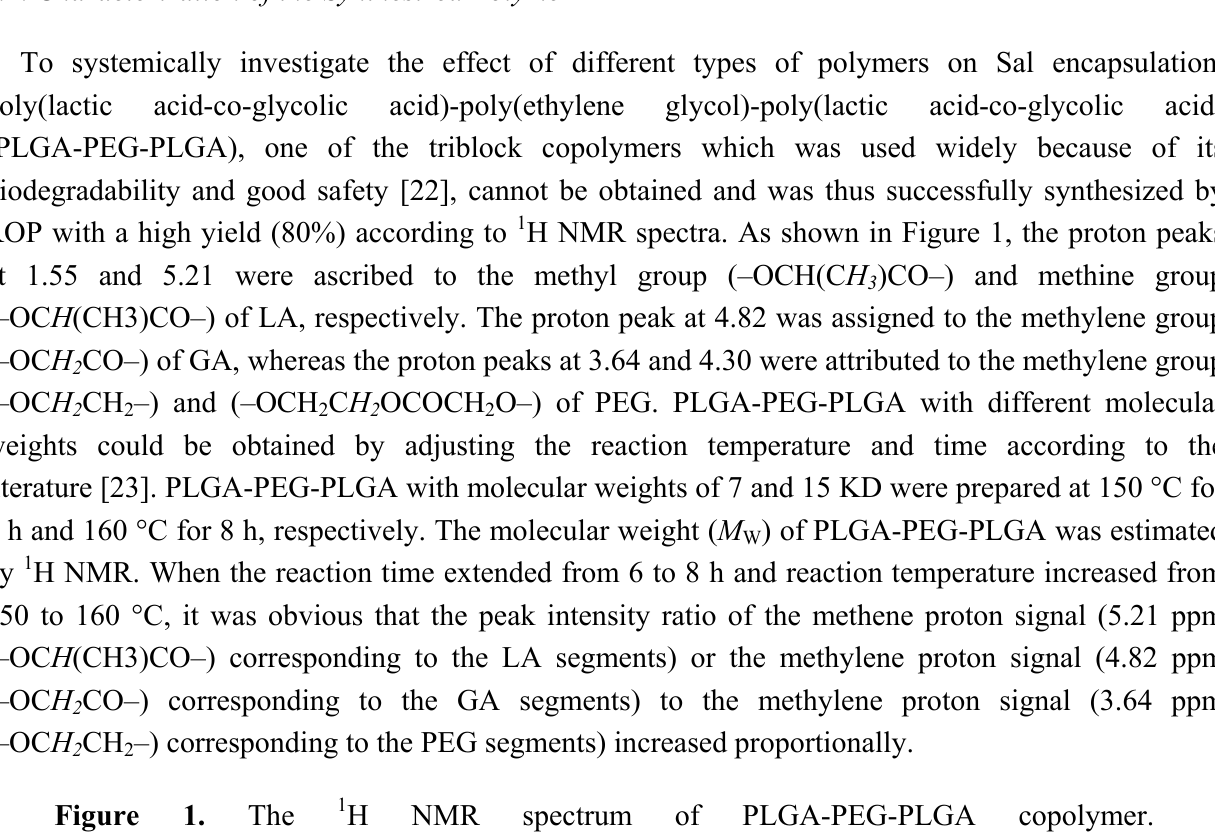
)CO–), δ 3.64 (–OC H 3 CO–) and δ 5.21 (–OC H (CH 2